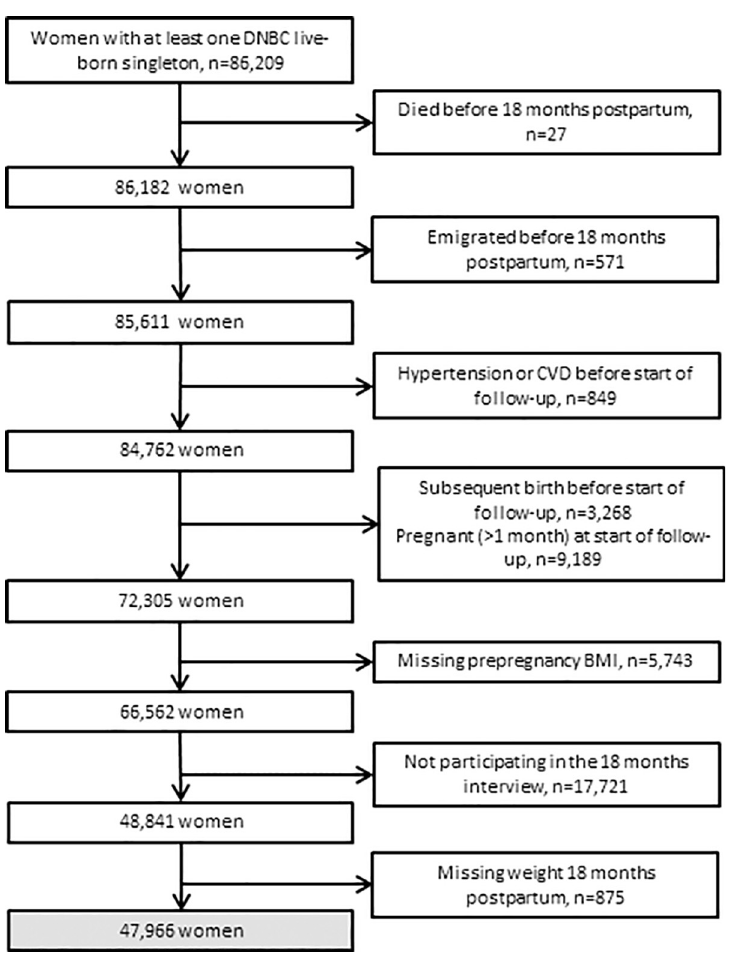
Fig 1. Flowchart of the study population. C AU : AnabbreviationlisthasbeencompiledforthoseusedthroughoutFig 1 : Pleaseverifythattheentriesarecorrect : VD, cardiovascular disease; DNBC, Danish National Birth Cohort.